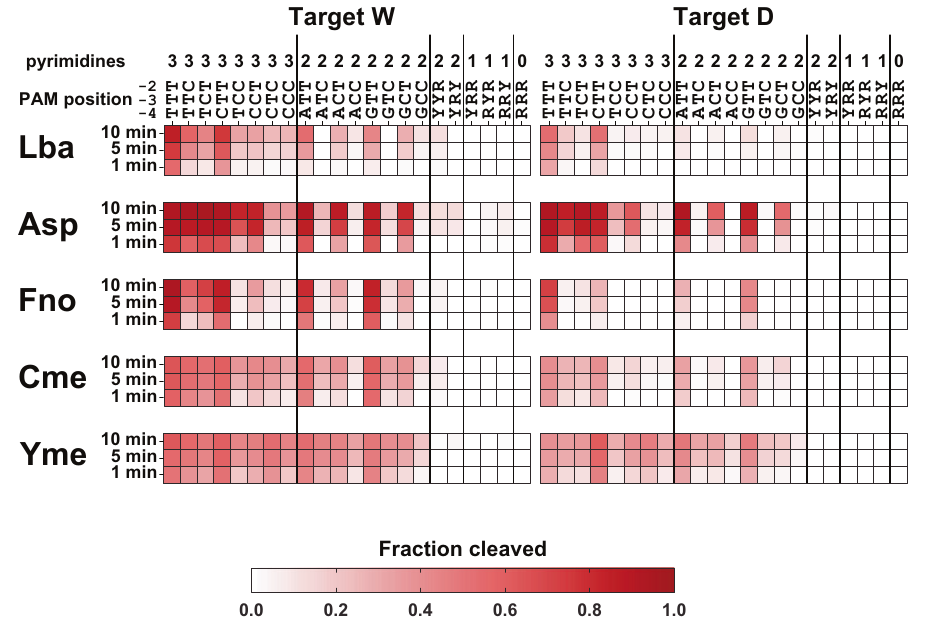
Fig. 4 Tolerance of non-canonical PAMs by Cas12a orthologs. Target-directed double-stranded DNA (dsDNA) cleavage activities of Cas12a RNPs were measured using in vitro assays containing fl uorophore-labeled dsDNA target substrates in the presence of a 10-fold mass excess of HeLa genomic DNA. Target dsDNAs were identical except for nucleotide identity at the − 2, − 3, and − 4 positions relative to the fi rst nucleotide of the target sequence. Aliquots from cleavage reactions were removed and quenched after 1, 5, 10 min. Cleaved fragments were quanti fi ed and the proportion of the substrate cleaved in each condition is represented in a heatmap where the intensity of the red color corresponds to the extent of target cleavage. Reactions were performed at 37 °C for Lba, Asp, and Fno while Cme and Yme reactions were performed at 55 °C. The source data used to make the graphs can be found in Supplementary Data